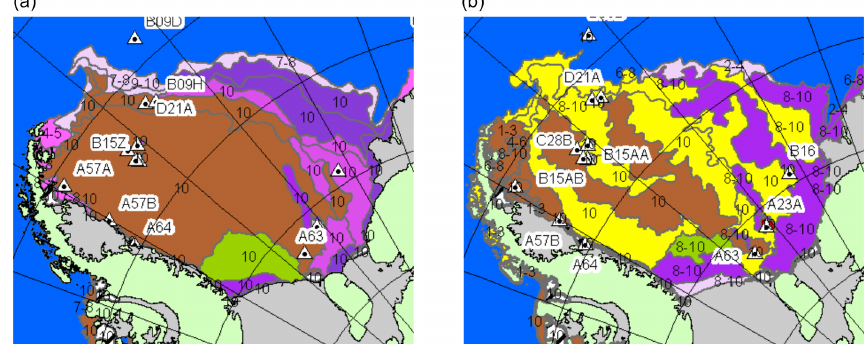
Figure 5. Stage of development (SoD) charts of the Weddell Sea, 30 March 2017, from AARI (a) and NIC (b) . FYI is yellow, MYI (“old ice”) is brown (see also the colour legend in the Appendix B, Table B1). The triangle symbols denote large icebergs.